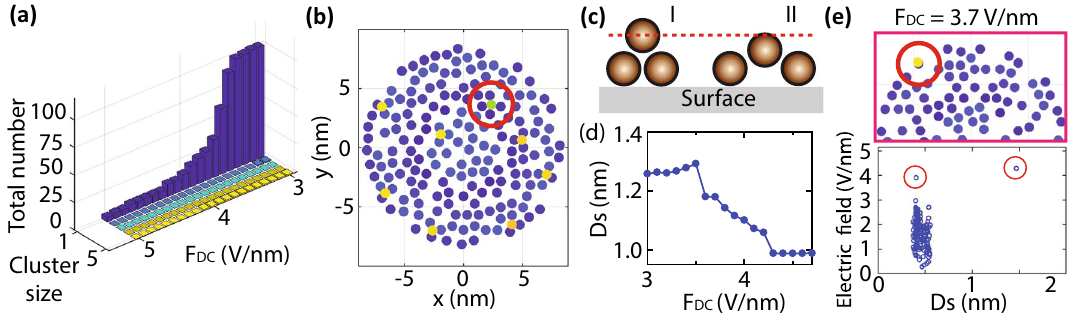
Figure 7. Molecule configurations at the high electric fields. ( a ) DC-electric-field dependence of a histogram of cluster size. The size of a cluster was determined by counting the number of molecules that were closely connected with each other. If two molecules are located within 11 Å, we defined them as connected. ( b ) Front view of the upper panel in Fig. 6c. The molecule marked by a red circle is the one remaining in Fig. 6d. ( c ) A schematic diagram of two kinds of molecule protrusions with different configurations. ( d ) The DC-electric-field dependence of average Ds at the second layer. ( e ) Another example of a molecule protrusion at high electric fields. Optimized molecule configurations on a tip (upper panel) and the plots of electric fields versus Ds (lower panel). The colour of the upper panels represents Ds